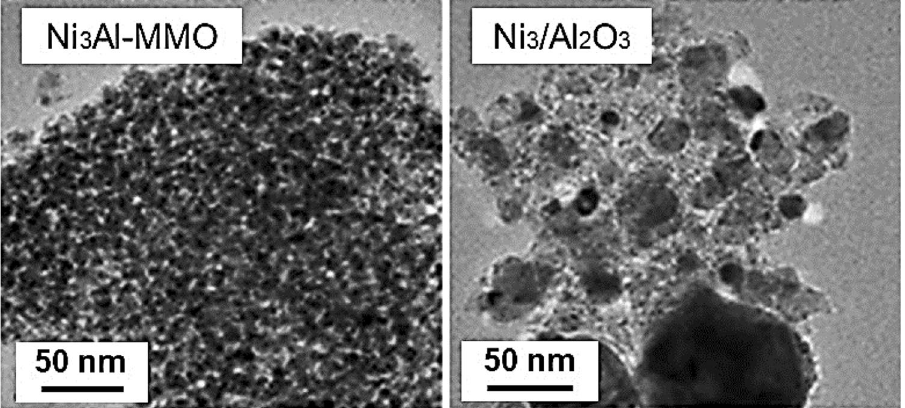
Fig. 6 TEM image of NiAl/ MMO catalyst prepared through co-precipitation and Ni/Al 2 O 3 fabricated through conventional impregnation